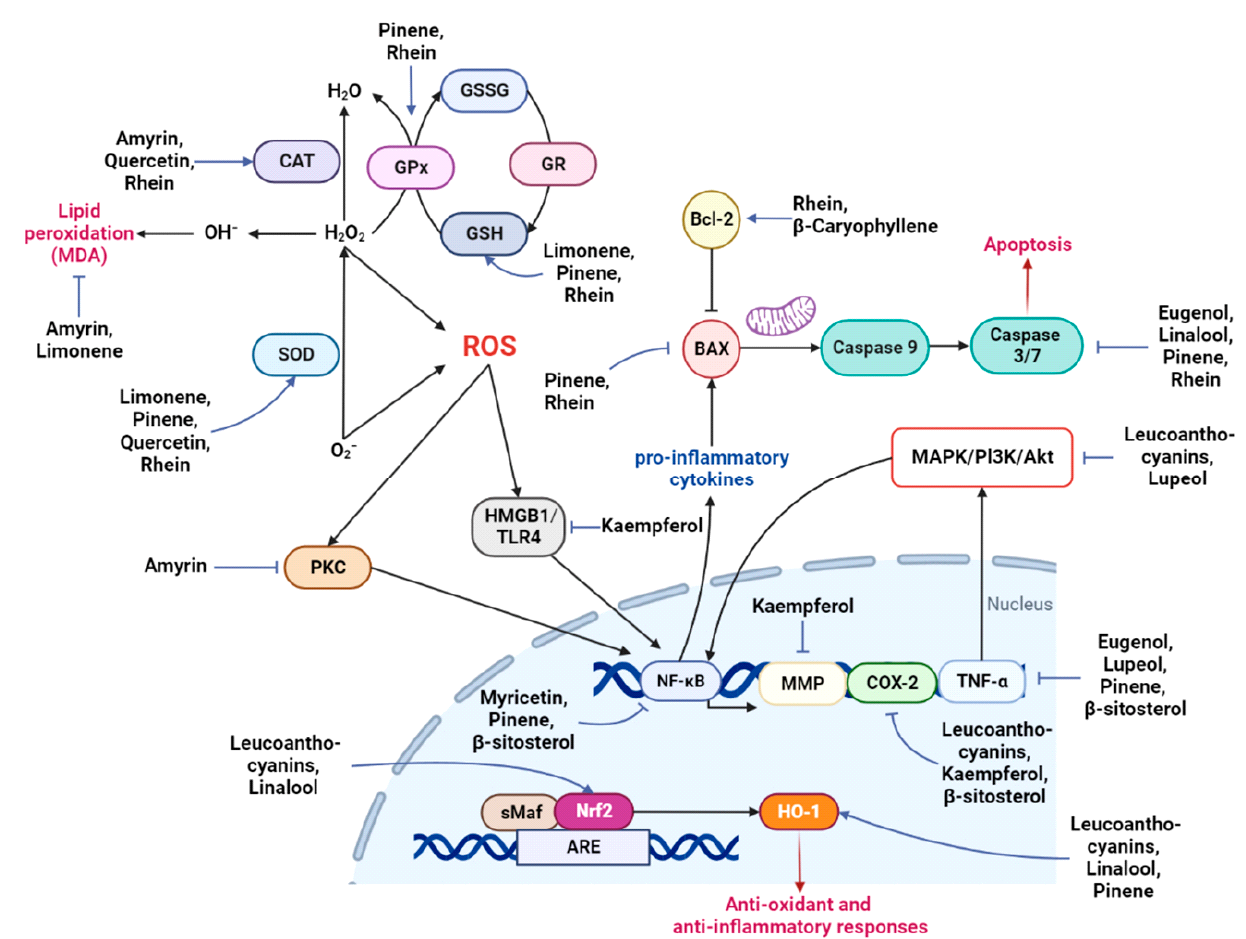
Figure 2. Mechanism of neuroprotection by various important phytochemicals from F. religiosa and F. benghalensis . Major phytochemicals act as inhibitors against oxidative stress and inflammation pathways. Oxidative stress is modulated by triggering antioxidant enzymes or transcription factors and suppressing ROS-mediated proteins. The cascade of inflammation is hampered by the down-regulation of inflammatory transcription factors and caspase-related components. Abbreviations: CAT, catalase; GPx, glutathione peroxidase; GR, glutathione reductase; GSH, glutathione; GSSG, oxidized glutathione; GST, glutathione S-transferase; SOD, superoxide dismutase; ROS, reactive oxygen species; MDA, malondialdehyde; PKC, protein kinase C; HMGB1, high mobility group box 1; TLR4, toll-like receptor 4; Bcl-2, anti-apoptotic B cell lymphoma-2; Bax, Bcl-2-associated X; NF- κ B; nuclear factor kappa B; MAPKs, mitogen-activated protein kinases; PI3K, phosphoinositol-3 phosphate; AKT, protein kinase B; MMP, matrix metalloproteinase; COX-2, cyclooxygenase 2; TNF- α , tumor necrosis factor α ; sMAF, small musculoaponeurotic fibrosarcoma protein; Nrf2, nuclear E2-related factor 2; ARE, antioxidant response element; HO-1, heme oxygenase-1.